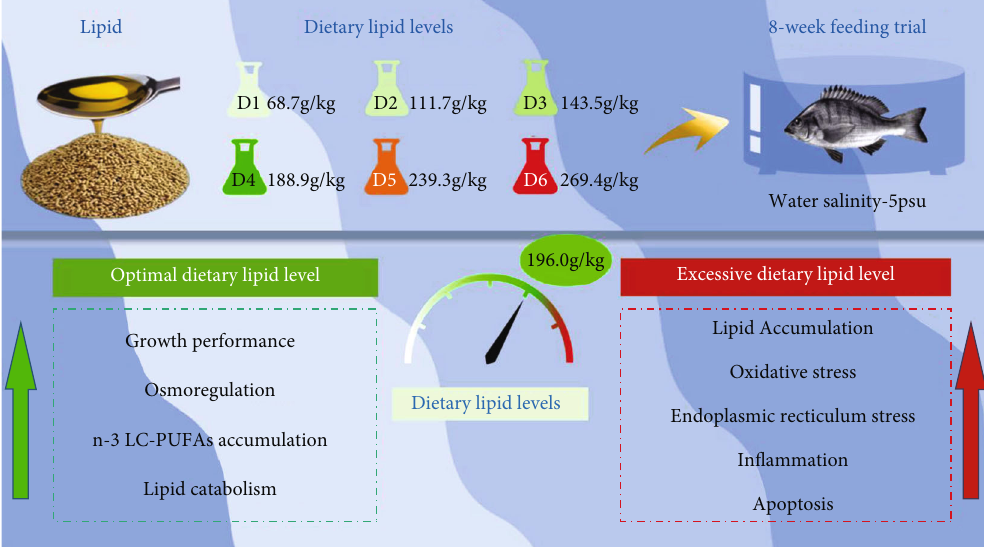
Figure 8: E ff ects of di ff erent dietary lipid levels on growth performance, osmoregulation, lipid metabolism, and physiological responses of juvenile Acanthopagrus schlegelii under low-salinity environment. Green/red arrows represent